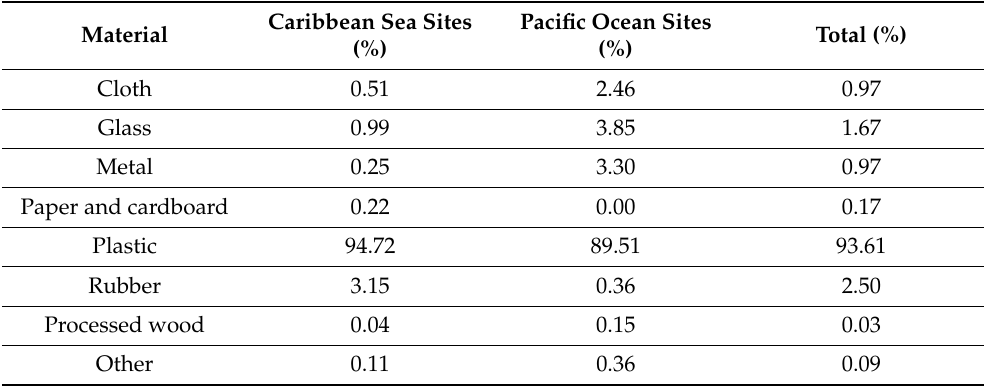
Table 3. Litter proportion (%) per type of material in the Caribbean and Pacific coasts of Colombia.